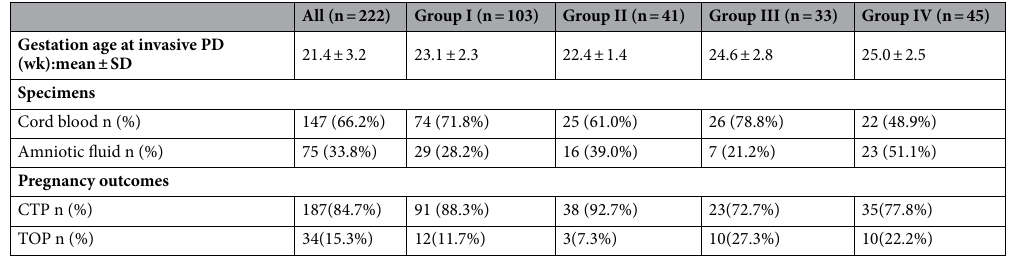
Table 1. Demographic characters for 222 pregnant women of ventriculomegaly in fetuses. PD prenatal diagnosis, SD standard deviation, CTP continuation of pregnancy, TOP termination of pregnancy.